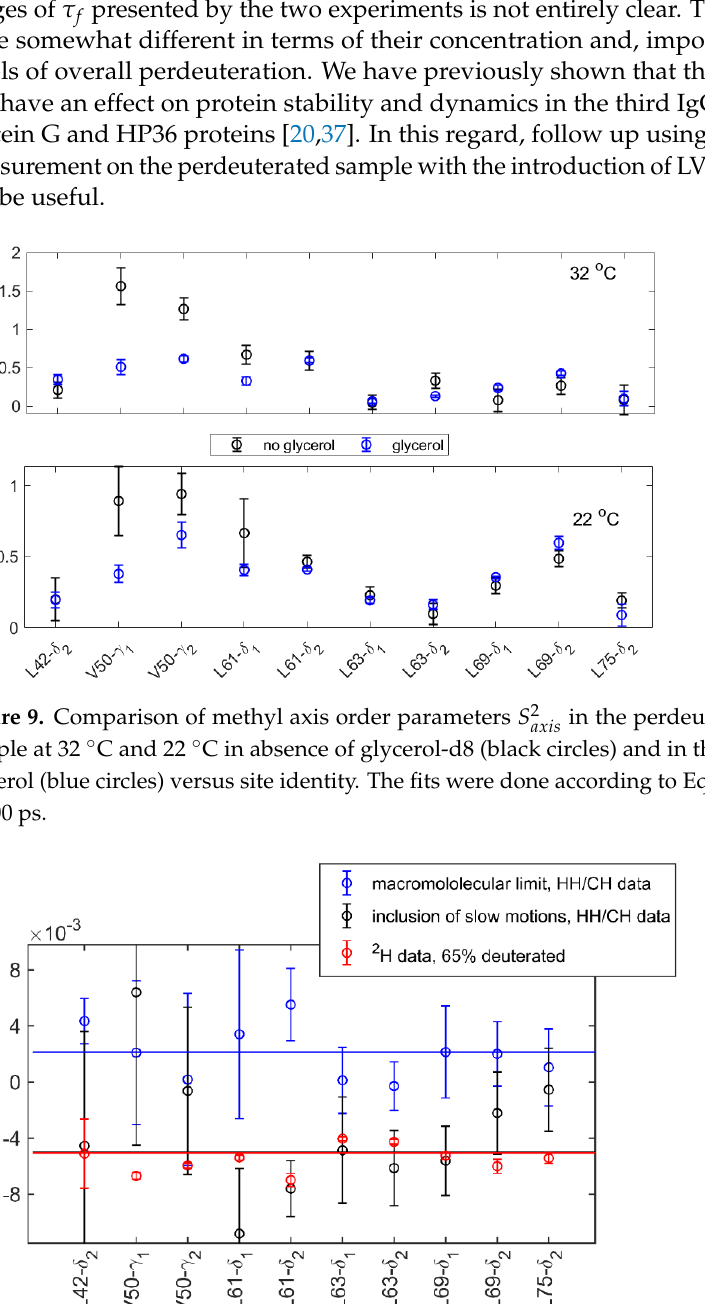
2 Figure 10. Comparison of slopes dS axis as a function of residue identity for perdeuterated/LV proto- dT nated HP36 protein using the H i -H j /H i -C cross-correlated relaxation rates and fitted either to the macromolecular limit (blue) or with the inclusion of slow motions of the methyl axes (black). The slow motions were included using the spectral density of Equation (4) and τ f = 500 ps for all sites except for V50 and L61, for which the spectral density of Equation (6) and τ f = 1 ns was used. The slopes for the prior data using the 65% deuterated HP36 protein characterized with 2 H relaxation are shown in red. 14 The solid lines represent the corresponding weighted